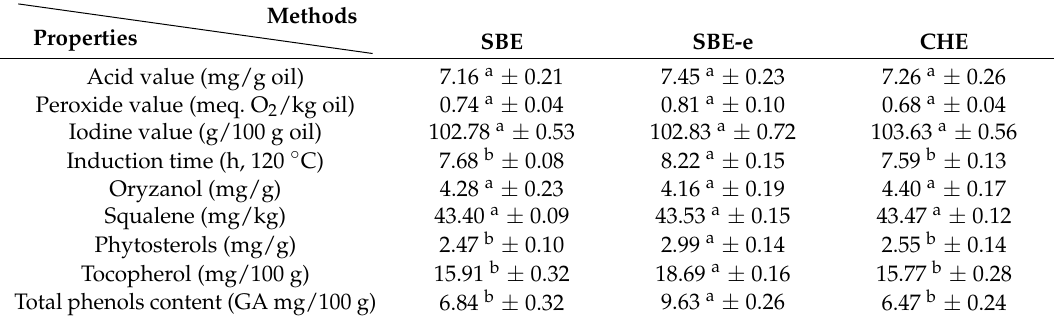
Table 4. Physicochemical characteristics of OBO extracted by different